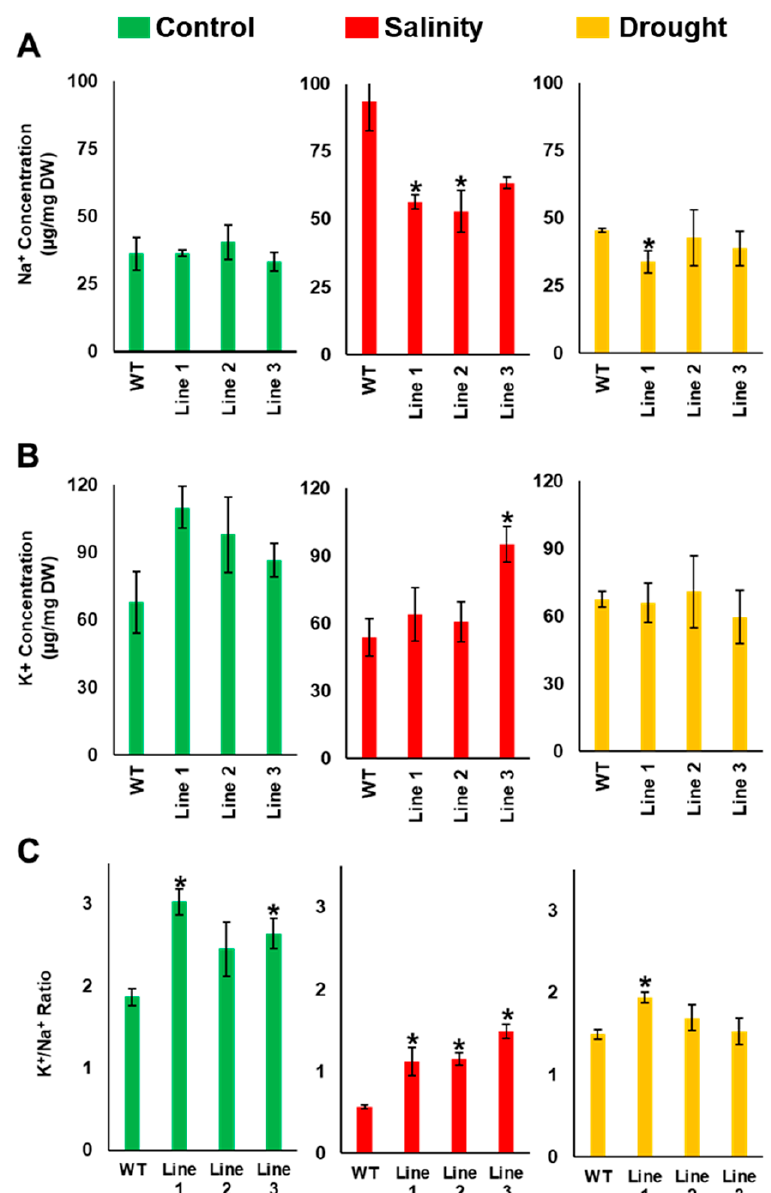
Figure 6. The e ff ect of PdMT2A on the accumulation of Na + and K + content in Arabidopsis . Accumulation Figure 6. The effect of PdMT2A on the accumulation of Na + and K + content in Arabidopsis . of Na + ( A ) and K + ( B ) and the K + / Na + ratio ( C ) in PdMT2A transgenic and WT Arabidopsis plants Accumulation of Na + ( A ) and K + ( B ) and the K + /Na + ratio ( C ) in PdMT2A transgenic and WT Arabidopsis plants when subjected to control, drought (150 mM mannitol) and salinity (100 mM NaCl) conditions on half-strength MS-medium plates. The bars represent the mean concentrations of Na + and K + (± SE, n = 3), while the asterisks indicate a significant difference from the WT plants ( p < 0.05). The effect of abiotic stress on photosynthesis was determined by measuring the chlorophyll levels. The transgenic lines had significantly ( p < 0.05) higher levels of chlorophyll under salinity, compared to the WT plants. Moreover, under drought and oxidative stress conditions, chlorophyll retention was greater in transgenic lines (Figure 7A).